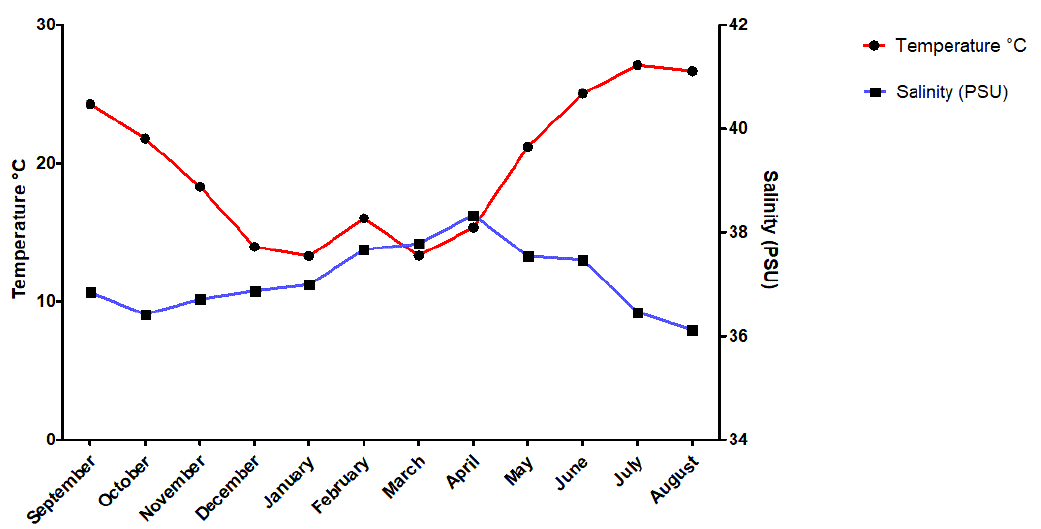
Figure 1. Diagrams showing monthly variations of temperature ( ◦ C) and salinity (PSU) in the sampling site.